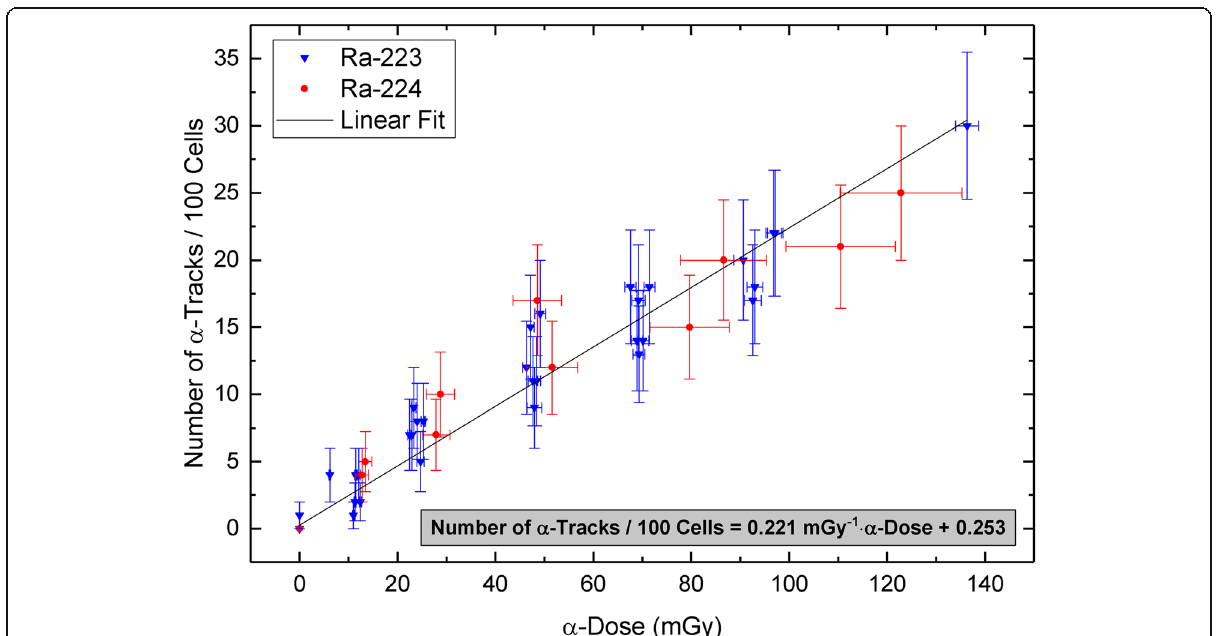
Fig. 3 Number of α -tracks per 100 cells after irradiation with Ra-223 (blue triangles; samples from six test persons; data taken from [19]) and Ra-224 (red dots; TP2 and TP3 only) as a function of the α -dose. The straight line represents a linear fit to the pooled